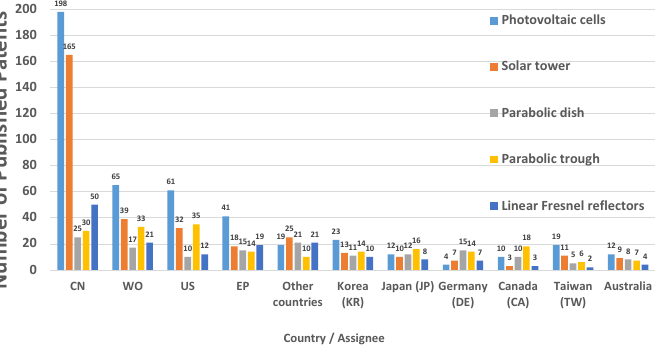
Figure 7. Number of patents and solar energy technologies in ORC application for different coun-